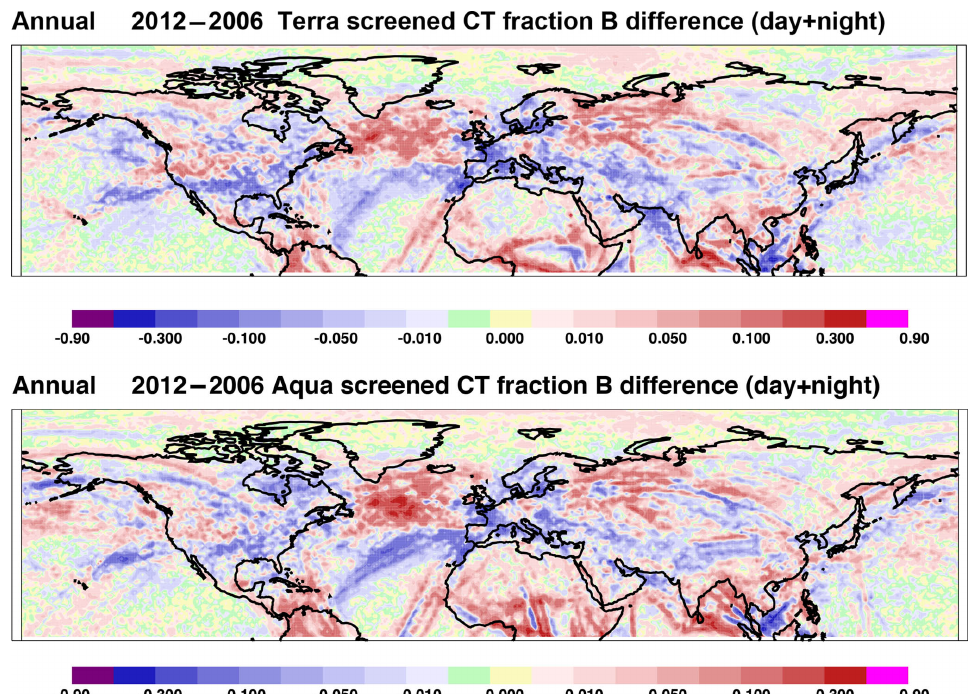
Figure 3. Difference (2012 minus 2006) in the annual-mean screened NH CC (in percent) from Terra and Aqua MODIS imagery (Mask B).